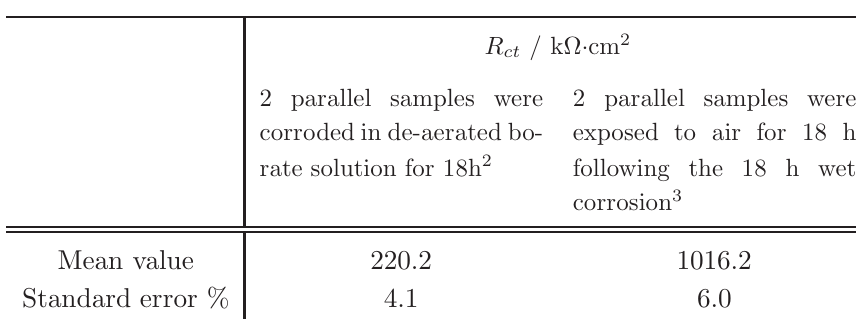
Table 4 Reproducibility of the fitted charge-transfer resistances of the corrosion process of Fe Ni Cr 29 51 20